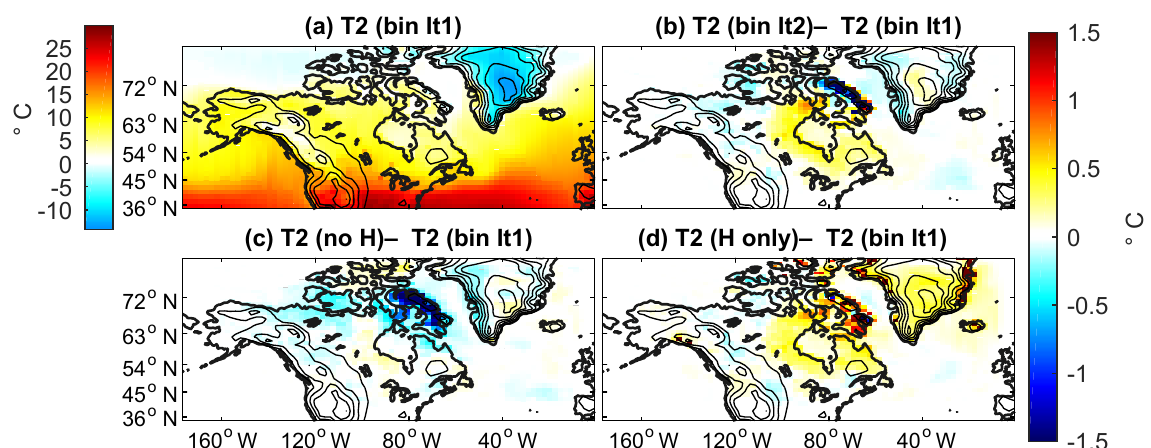
Figure 11. Changes in 2m summer temperature in the parent domain for topography and ice sensitivity simulations. (a) The 2m temperature for the Iteration 1 simulation averaged during the summer (JJA). (b) Differences during the summer between Iterations 1 and 2. (c) Differences between the Iteration 1 and “no H ”. (d) Differences between Iteration 1 and “ H only”.